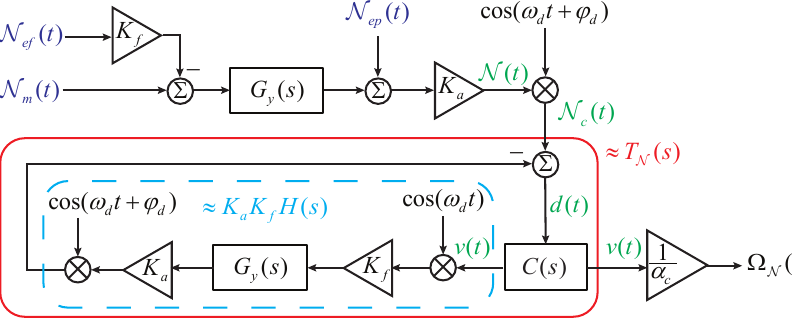
Figure 9. The equivalent noise model of the force-rebalance sense